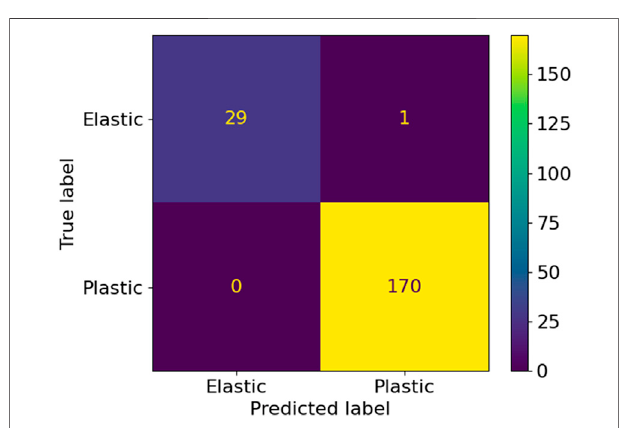
FIGURE 11 | Confusion matrix for 300 load cases and the ratio of 2:1 between 6D and 3D load cases.